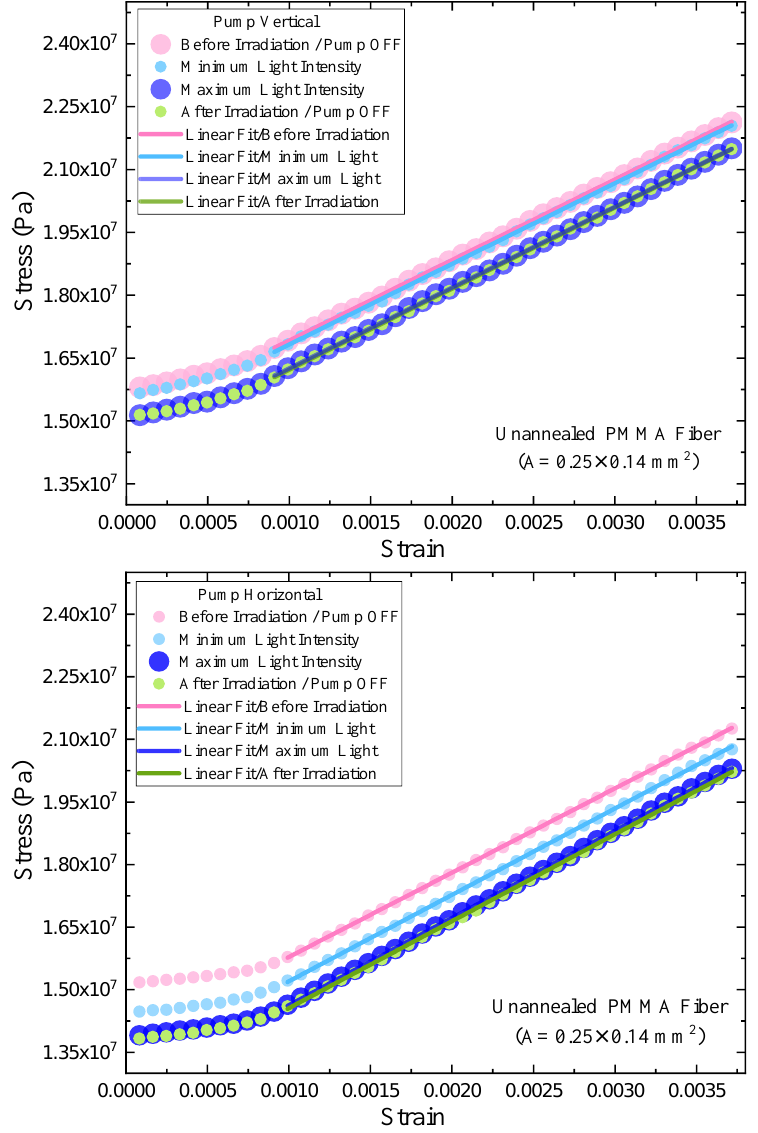
Figure 8. Stress versus Strain of unannealed PMMA fiber before, during, and after visible light irradiation with vertical and horizontal